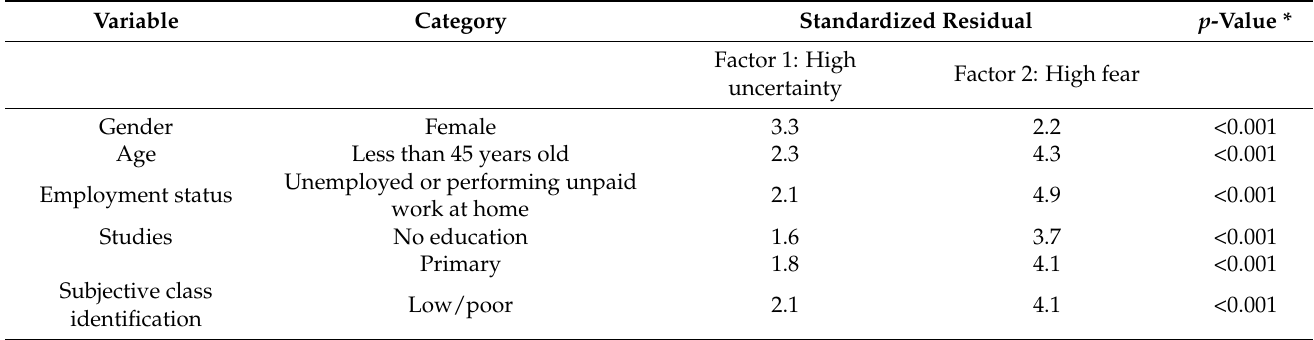
Table 3. Analysis of the standardized residuals.